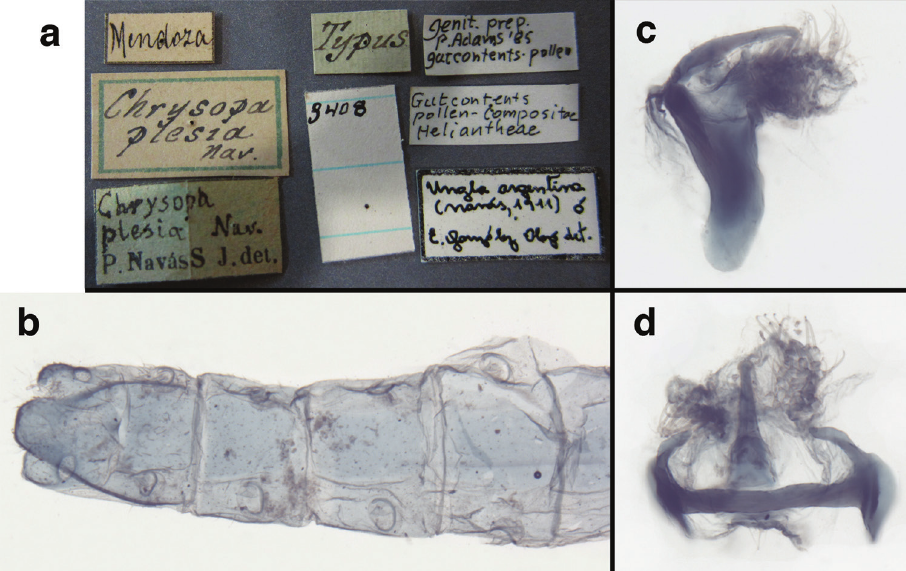
Figure 110. Chrysopa plesia Navás: Features, ( a ) labels ( b ) abdomen, dorsal, ( c ) gonarcus, lateral ( d ) gonarcus, dorsal (Argentina, Mendoza, lectotype, male, MLPA)